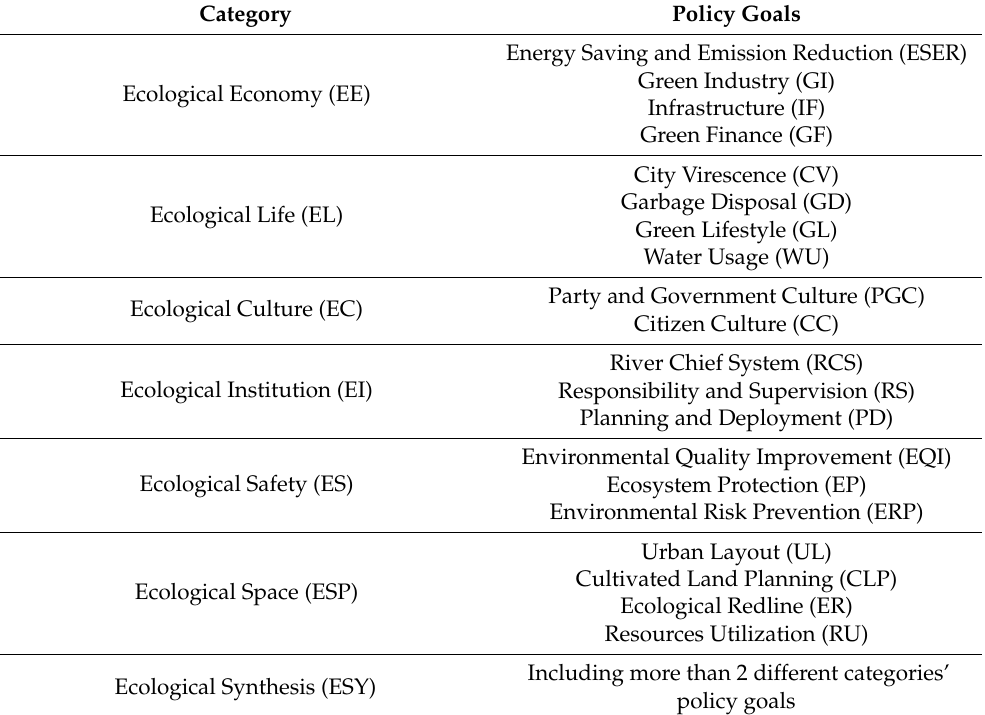
Table 1. Policy document classification. Category Policy Goals